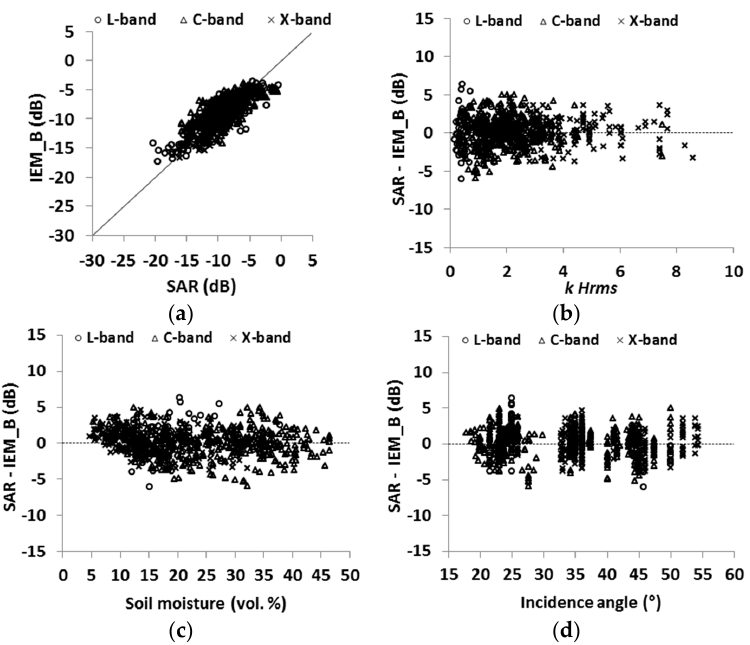
Figure 13. Comparison between backscattering coefficients derived from SAR images and those estimated from IEM_B at VV polarization using GCF. ( a ) IEM_B simulations vs. SAR data; ( b ) difference between SAR signal and IEM_B vs. soil roughness ( kHrms ); ( c ) difference between SAR signal and IEM_B vs. soil moisture ( mv ); ( d ) difference between SAR signal and IEM_B vs. incidence angle.